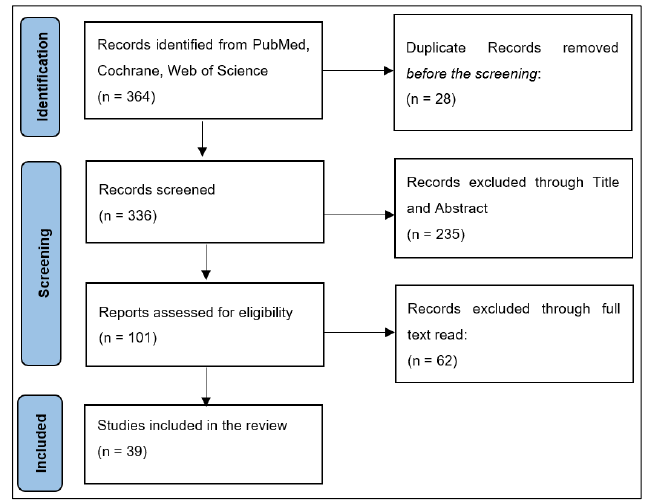
Figure 1. PRISMA flowchart for the study selection process.